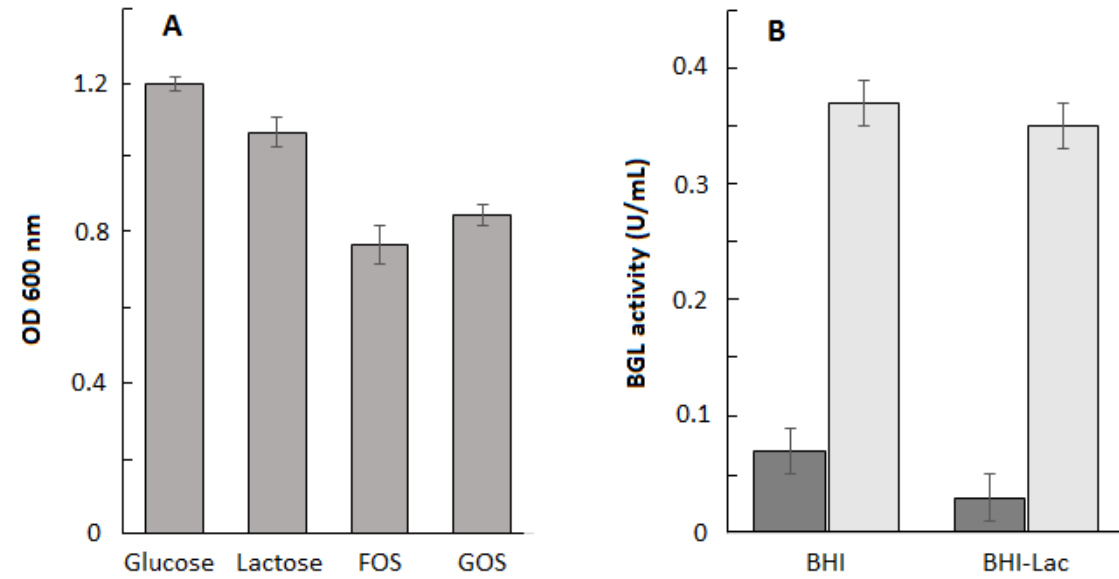
Figure 2 – Phenotypical characteristics of E. durans LAB18S. (A) Growth on different carbon sources. The strain was cultivated in medium containing 10 g/L glucose, lactose, FOS or GOS and the cell density was estimated by OD after 24 h at 37 o C. (B) The β-galactosidase (BGL) activity was measured 600 in the cell culture supernatant (dark gray bars) and cell lysates (pale gray bars) after growth in BHI or BHI supplemented with 10 g/L lactose (BHI-Lac). Values are the means ± standard deviations of three independent